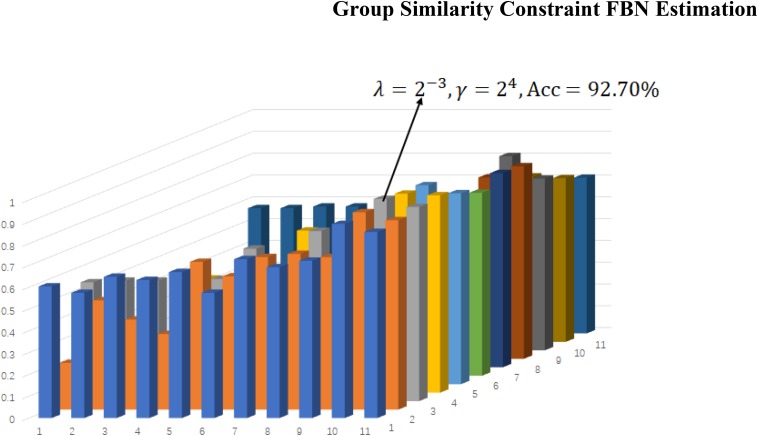
Classification accuracy based on the networks estimated by the proposed method with different regularized parametric values in the interval [2−5,25]. The results are obtained by LOO test on all subjects.